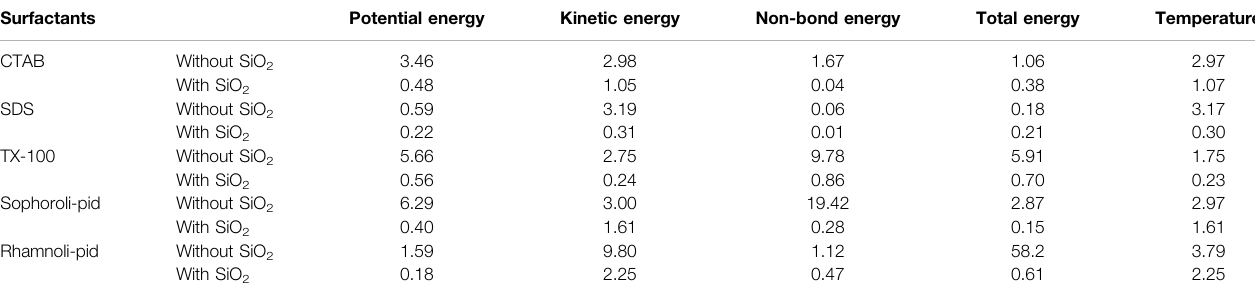
TABLE 1 | The energy change rate and temperature change rate (%) (1,500 – 2000 ps) of surfactants (with and without SiO 2 nanoparticles)